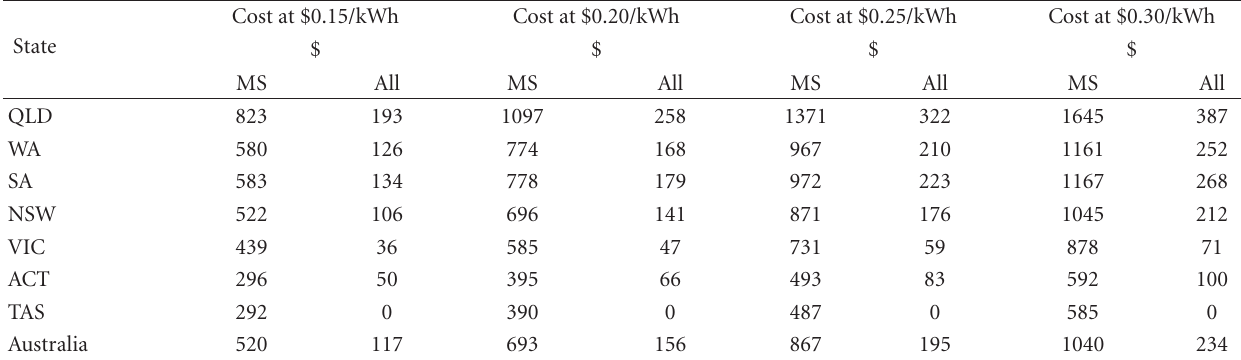
Table 4: Estimated annual mean costs of air-conditioner use in MS and all